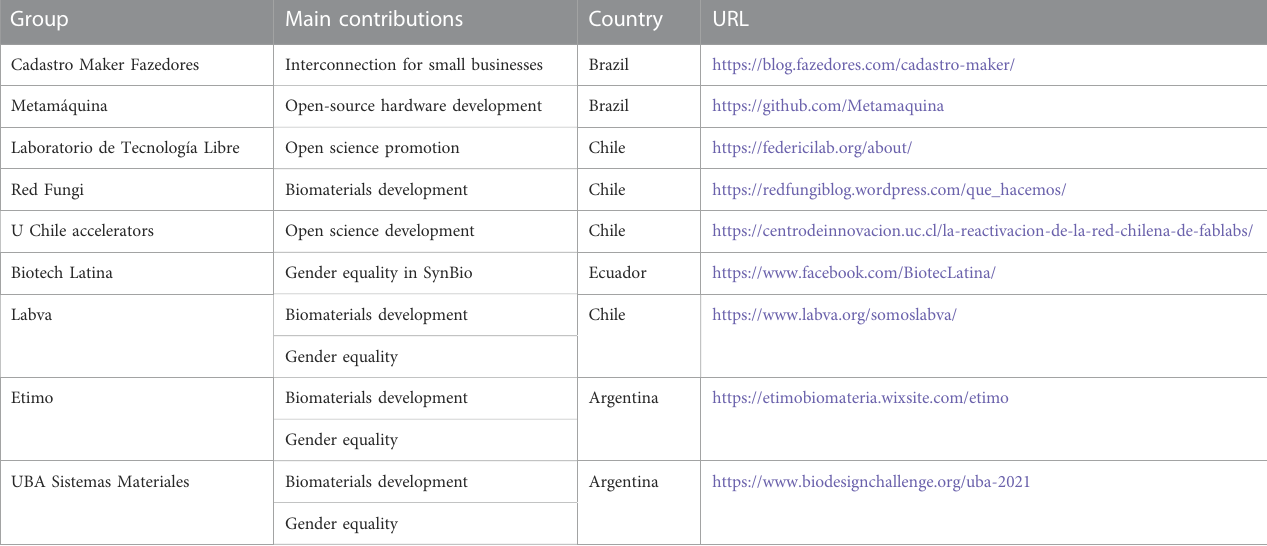
TABLE 3 Citizen and open science in South America. There are several groups, mainly in Argentina and Chile, that encourage the development of SynBio in society.